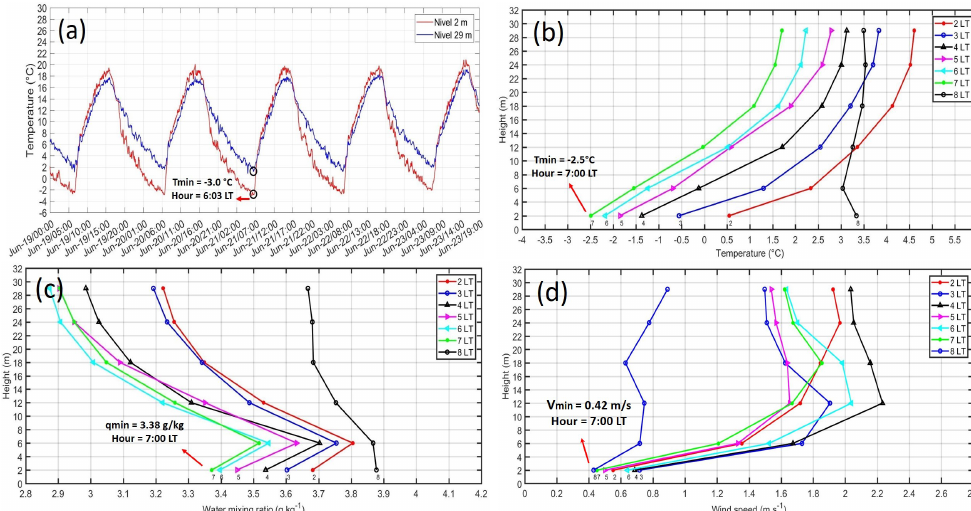
Figure 8. ( a ) Time series of air temperature ( ◦ C) at a height of 2 m and 29 m above the HYO between 19 June and 23 June, 2018. ( b ) Mean hourly vertical profiles of air temperature ( ◦ C) during night and early morning hours of 21 June 2018. ( c ) Mean hourly vertical profiles of water vapor mixing ratio (g kg − 1 ) during night and early morning hours of 21 June, 2018. ( d ) Mean hourly vertical profiles of wind speed (m s − 1 ) during night and early morning hours of 21 June